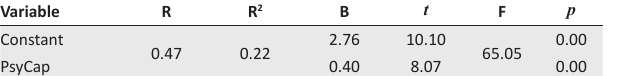
TABLE 3: Model summary for the relationship between psychological capital and organisational citizenship behaviour. Variable